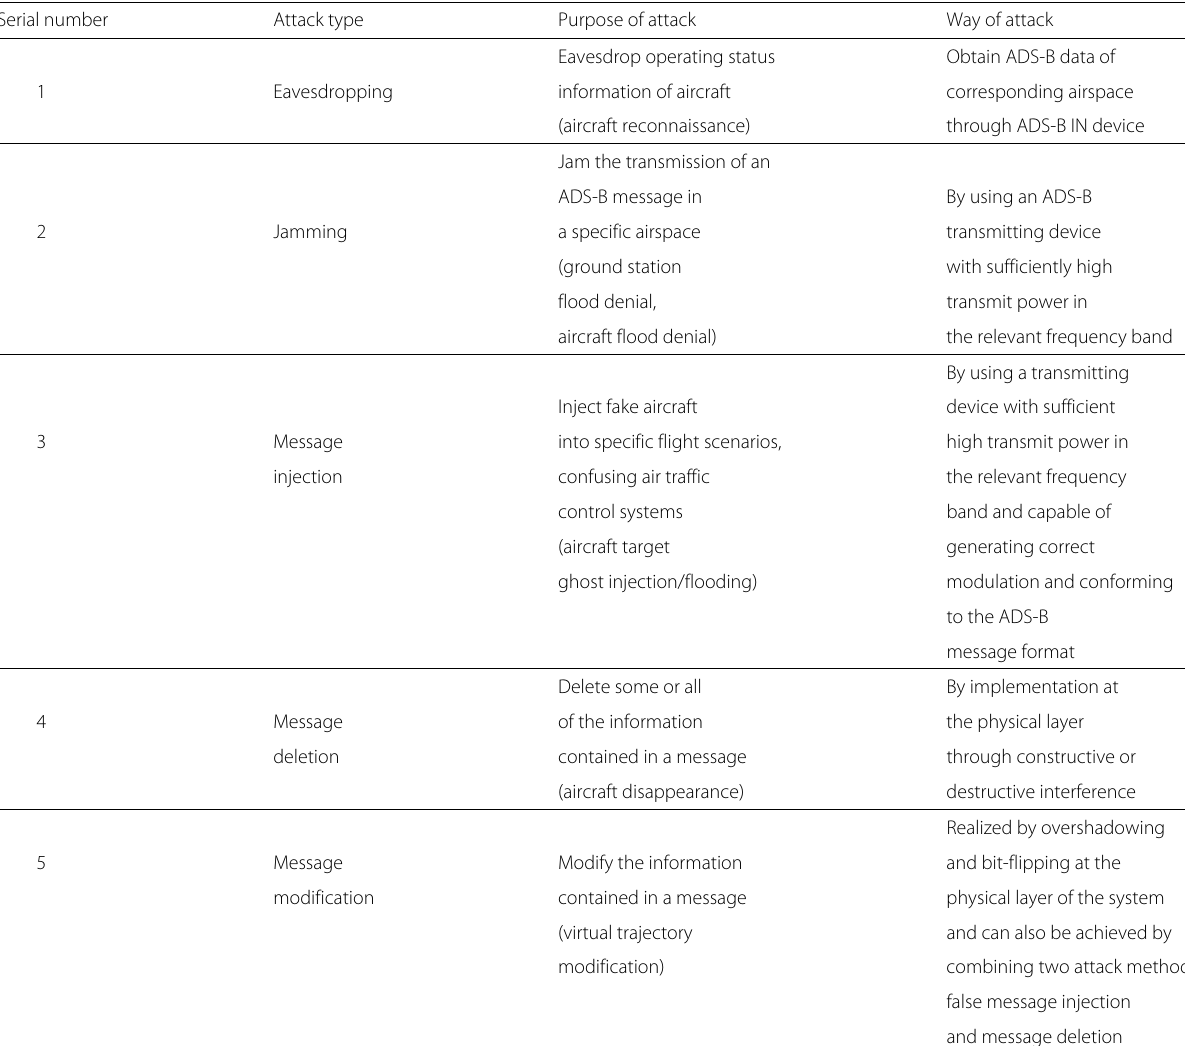
Table 1 ADS-B packet attack